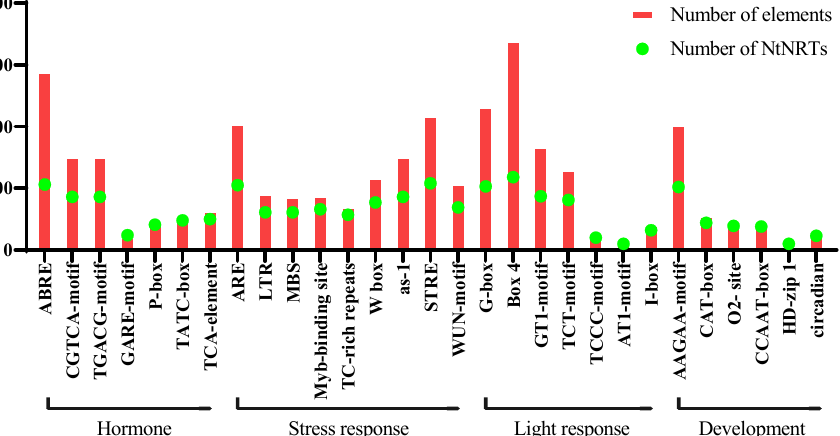
Figure 5. Identification of the cis -regulatory elements in the 2 kb promoter regions of the 117 NtNPF genes. The cis -acting elements were mainly categorized into development, hormone, light response, and stress response-related elements. The bar graph indicates the total number of each cis -acting element found in NtNPF promoters (red box) as well as the number of NtNPF genes which include a specific cis -regulatory element (green circle).